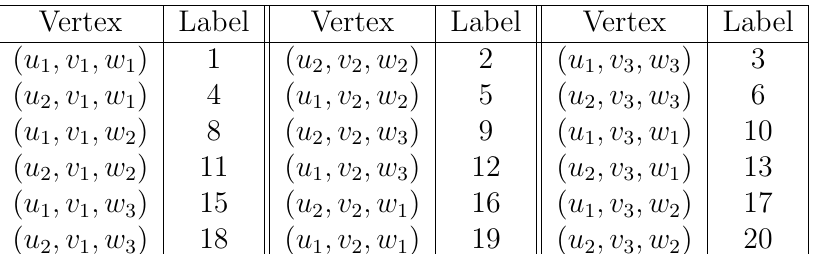
(cid:3) K (cid:3) K 2 3